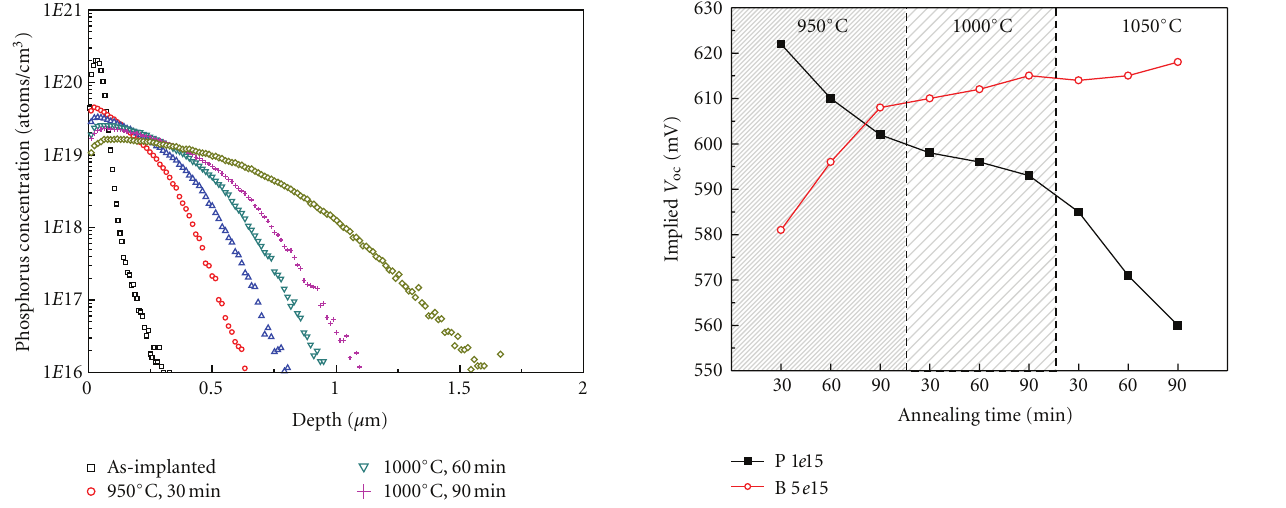
Figure 5: Implied V oc of ion-implanted samples with di ff erent annealing conditions measured using